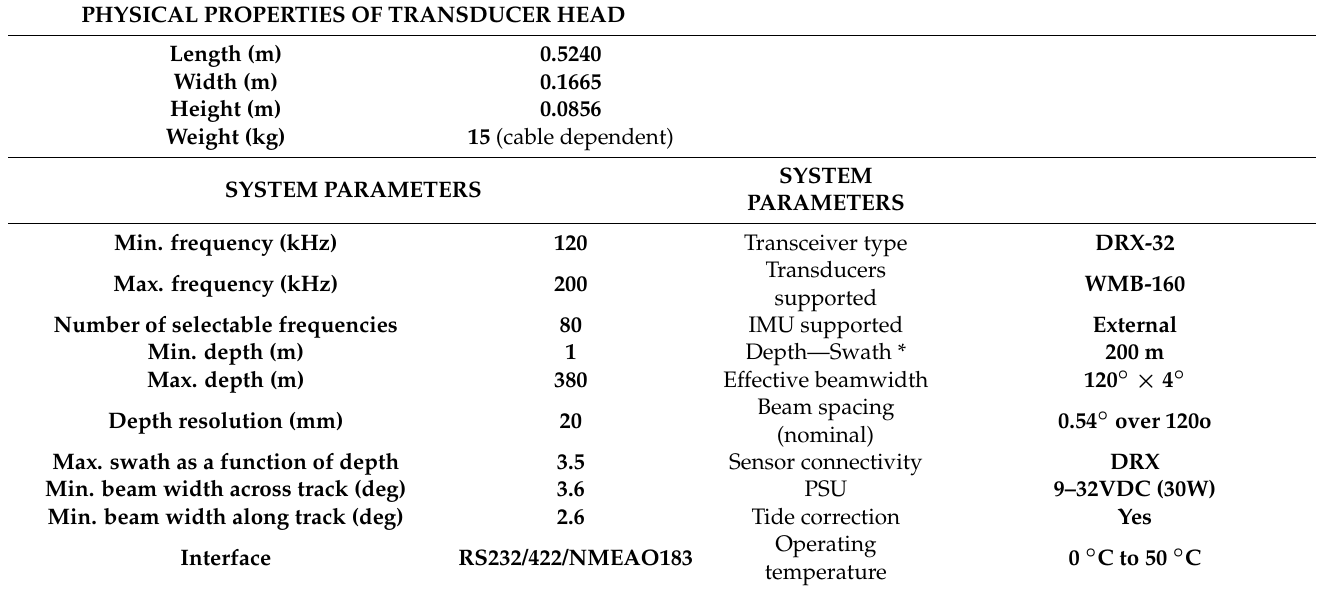
Table 1. The basic specification of the WASSP S3.